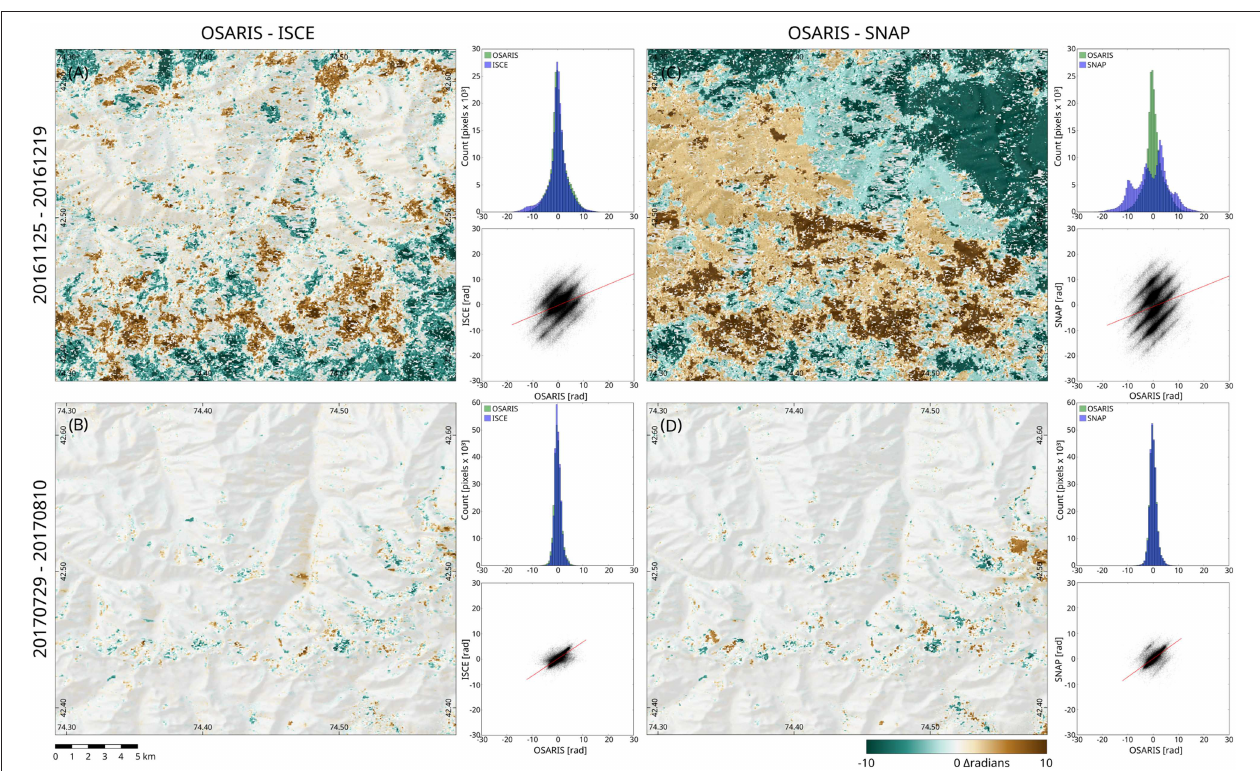
FIGURE 10 | Differences in unwrapped interferograms and corresponding SPAtial Efficiency metric results (histograms, scatter plots) for the core study area. (A) OSARIS—ISCE for the low-coherence pair 2016-11-25 to 2016-12-19, (B) OSARIS—ISCE for the high-coherence pair 2017-07-29 to 2017-08-10, (C) OSARIS—SNAP for the low-coherence pair 2016-11-25 to 2016-12-19, (D) OSARIS—SNAP for the high-coherence pair 2017-07-29 to 2017-08-10. Difference images for the wider study area are available in Figure S5 , the respective coherence results from the individual processors in Figure S6 . A semitransparent hillshade based on SRTM DEM data was added for orientation. Contains modified Copernicus Sentinel data